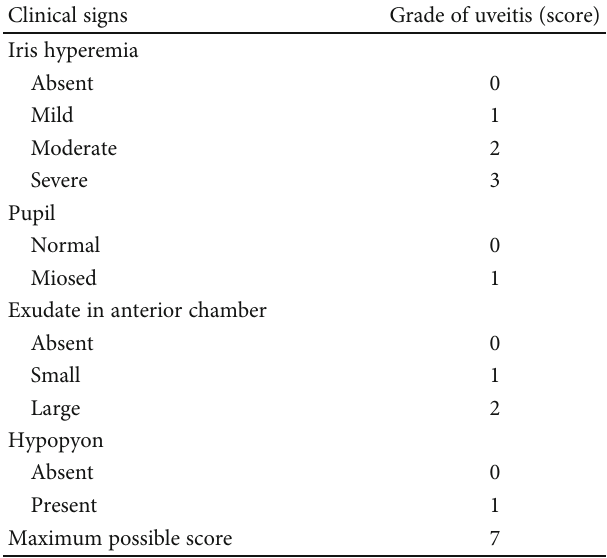
Table 1: Scoring system for clinical evaluation of uveitis.